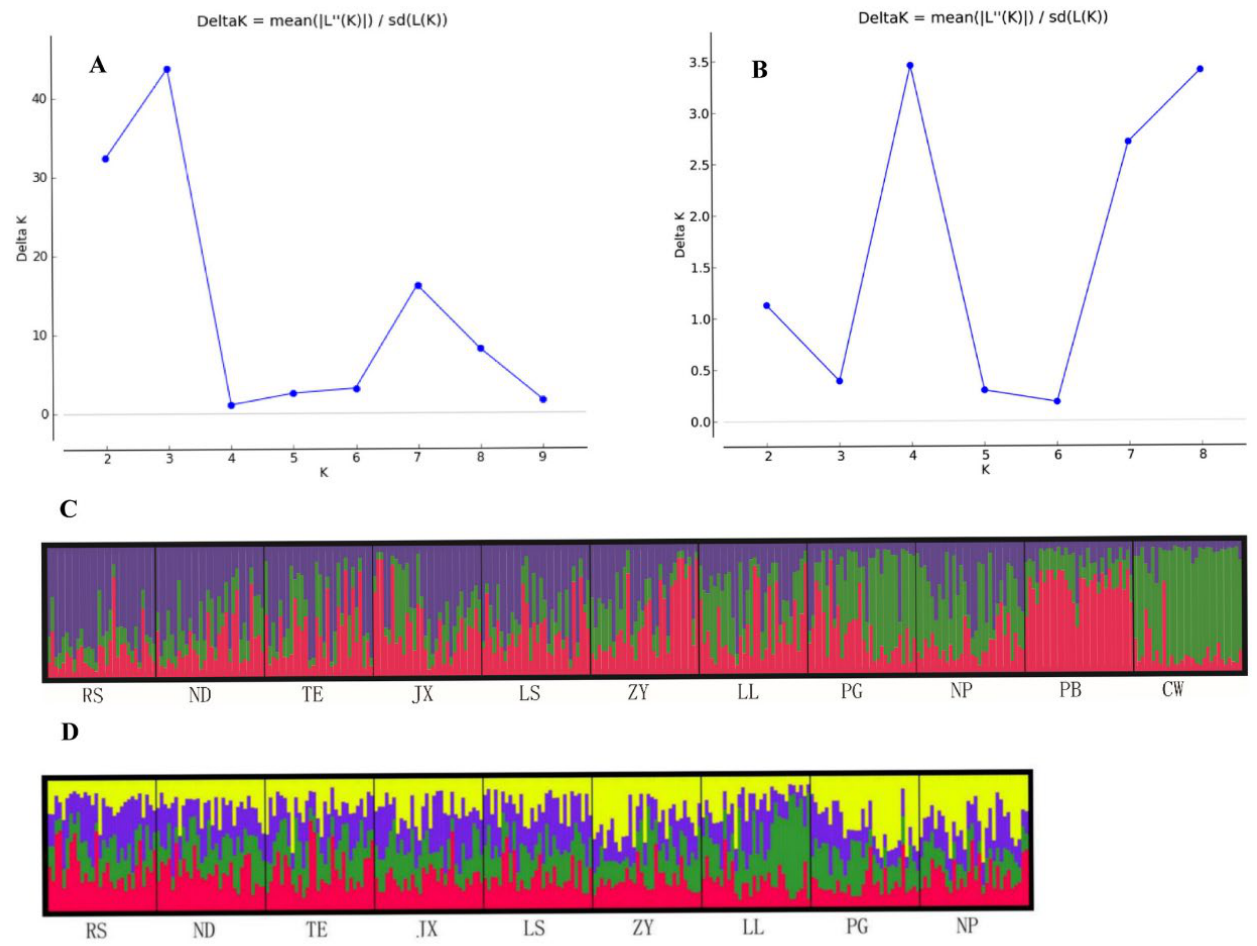
Figure 3. Population structure analysis for 11 and 9 sampling localities. ( A ) The best K value estimated by ln likelihood for 11 sampling localities. ( B ) The best K value estimated by ln likelihood for 9 sampling localities. ( C ) Bar plot of individual ancestral composition for the genetic clusters, using K = 3 and the dataset of 330 individuals from 11 sampling localities. ( D ) Bar plot of individual ancestral composition for the genetic clusters, using K = 4 and the dataset of 270 individuals from 9 sampling localities.